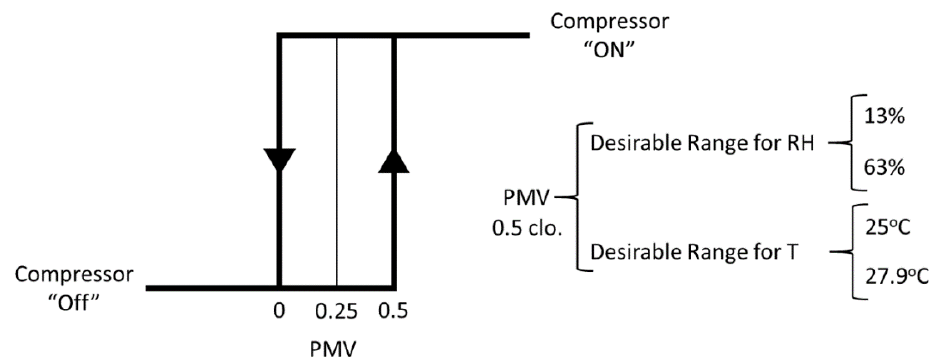
Figure 8. Setpoint for HVAC compressor.